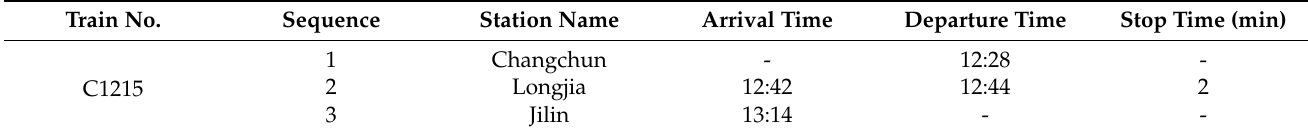
Table 1. An example of a railway timetable.